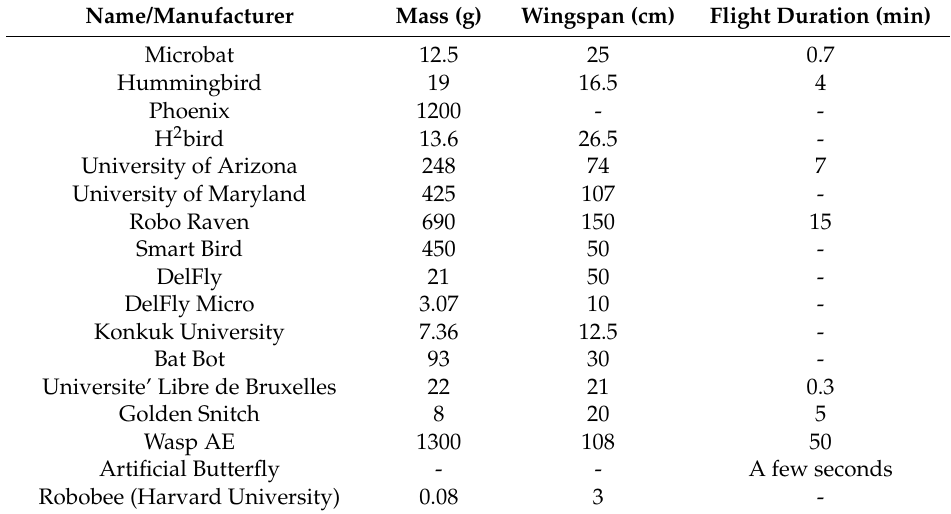
Table 1. Characteristics of the above FWMAVs.